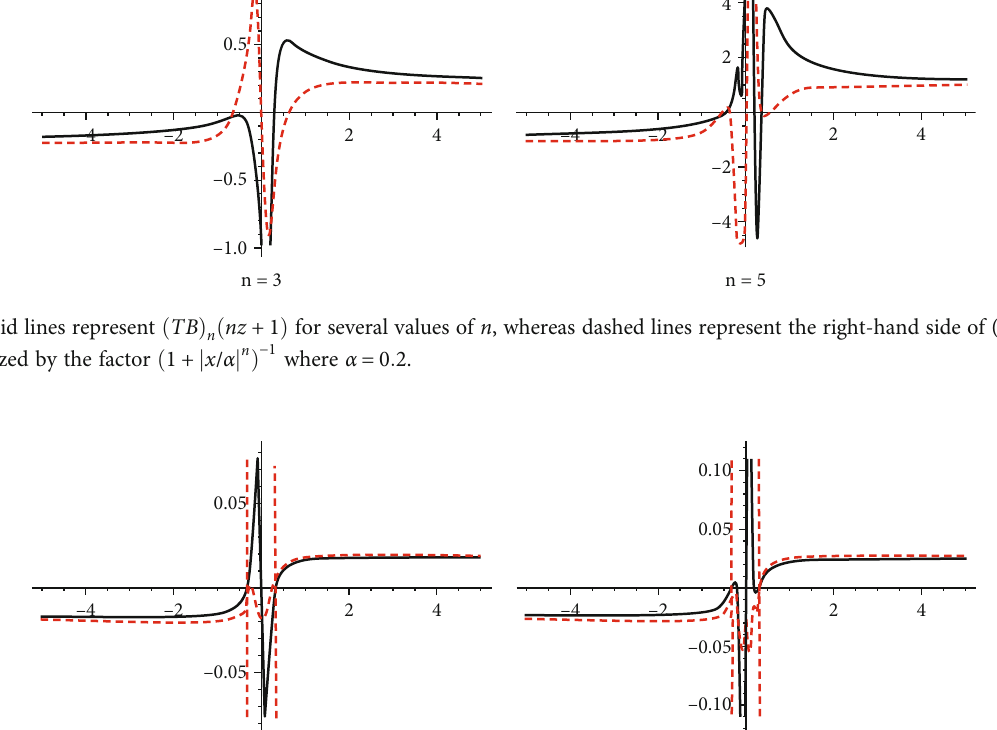
nz + 1 Þ for several values of n , whereas dashed lines represent the right-hand side of (43) with z ≡ x , n ð − 1 where α = 0 : 2 .